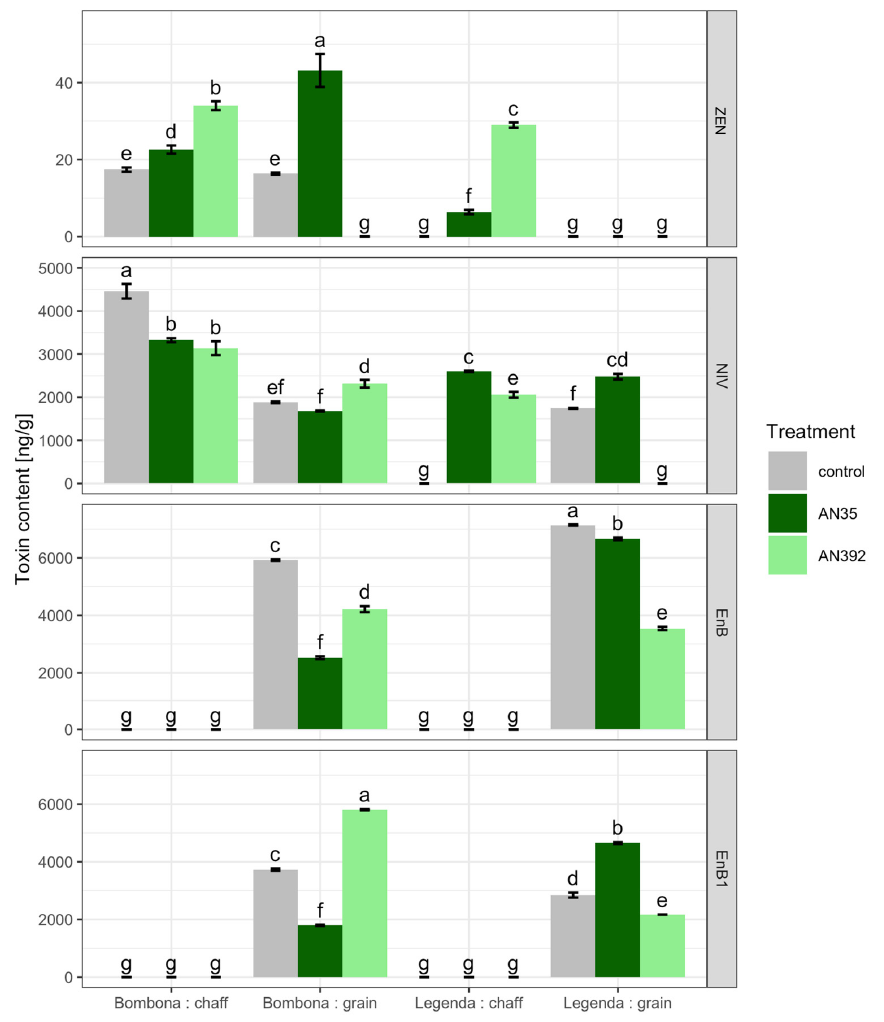
Figure 13. Toxin content in wheat kernels after Trichoderma root inoculation. Letters indicate significance groups within the row (for each toxin) according to Tukey’s test at 0.05.